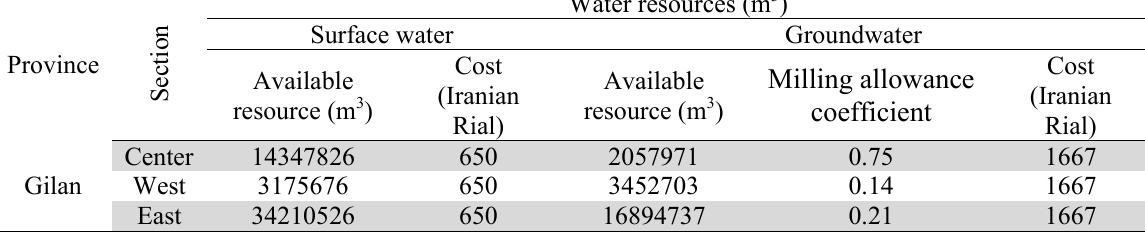
Available water resources and Groundwater mining allowance coefficient in each region Province